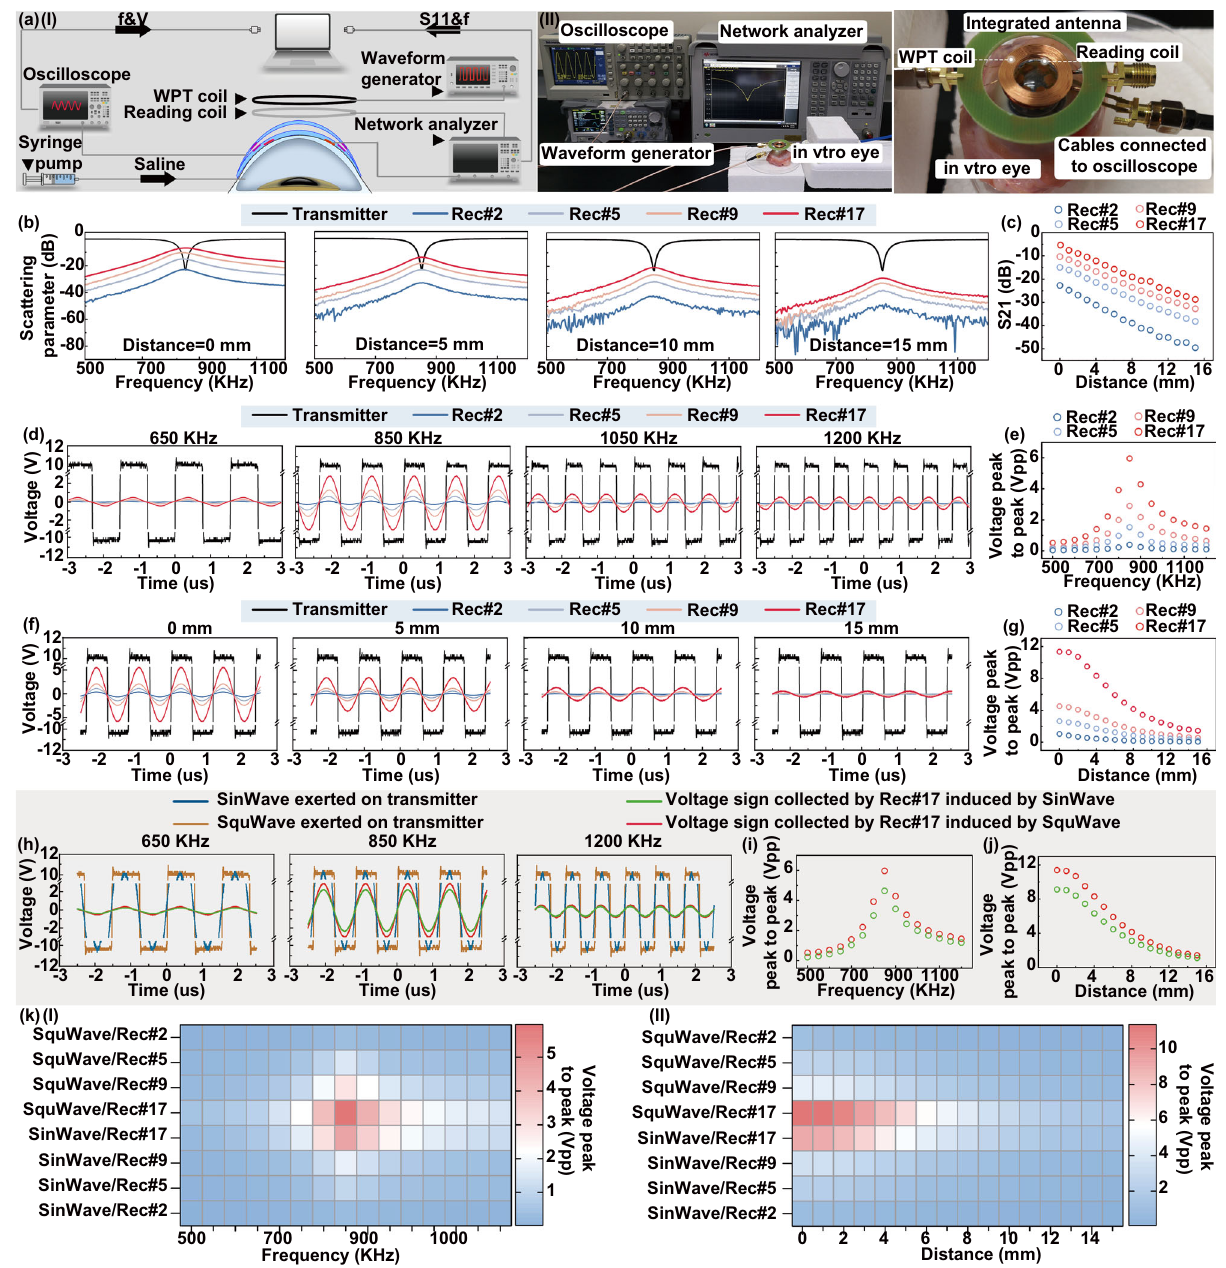
Fig. 4 WPT performance of the WTCL. a (I) Schematic and (II) experimental setup of the WPT experiments. b Re fl ection coef fi cient spectra (S11 and S21) were recorded from four receivers at different radiation distance. c The S21 recorded by the four receivers at 850 kHz were plotted as a function of radiation distance. d Alternating voltage signals collected from four receivers wirelessly under different frequency radiation at 20 Vpp applied on the transmitter, and ( e ) Wirelessly transferred alternating voltage waveforms of four receivers under different radiation distance at 20 Vpp applied on the transmitter, and ( f ) the Vpp were plotted as a function of frequency and ( g ) as a function of distance. h The wirelessly transferred voltage signals collected by Rec#17 were activated by SquWave or SinWave voltages at different frequencies, and the Vpp were plotted as a function of ( i ) frequency or ( j ) distance. k Heatmap plot summarized the Vpp recorded from four receive circuits under different voltage-transfer conditions, including the coupling frequency, the radiation distance, and the